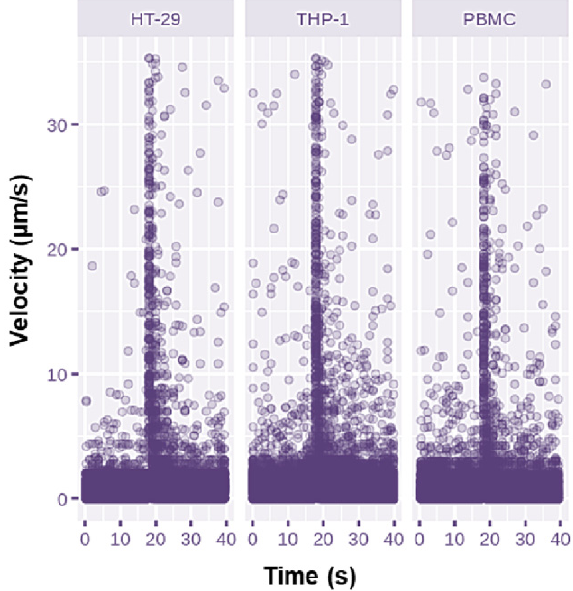
Figure 1. Cell velocities distribution measured with the applied voltage of Vpp = 12 V at 1 MHz. Cells were allowed to settle for 15 s in each acquisition in order to measure baseline displacement before the application of the DEP field.